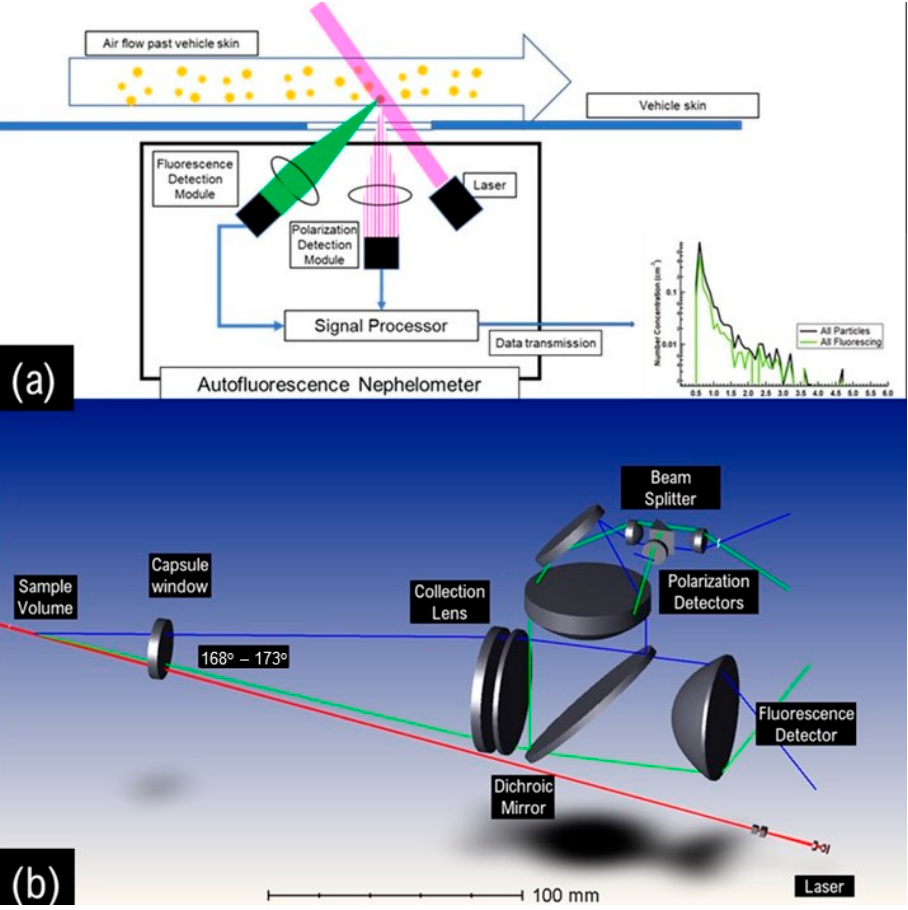
Figure 1. ( a ) This cartoon illustrates the basic features of the AFN in which a 440 nm diode laser projects a focused beam out a window into the air-stream where it is intercepted by individual cloud droplets that scatter light. Some may also fluoresce. The scattered and fluorescent light is collected and processed to derive size distributions and complex refractive indices, ( b ) This diagram shows the optical components of the